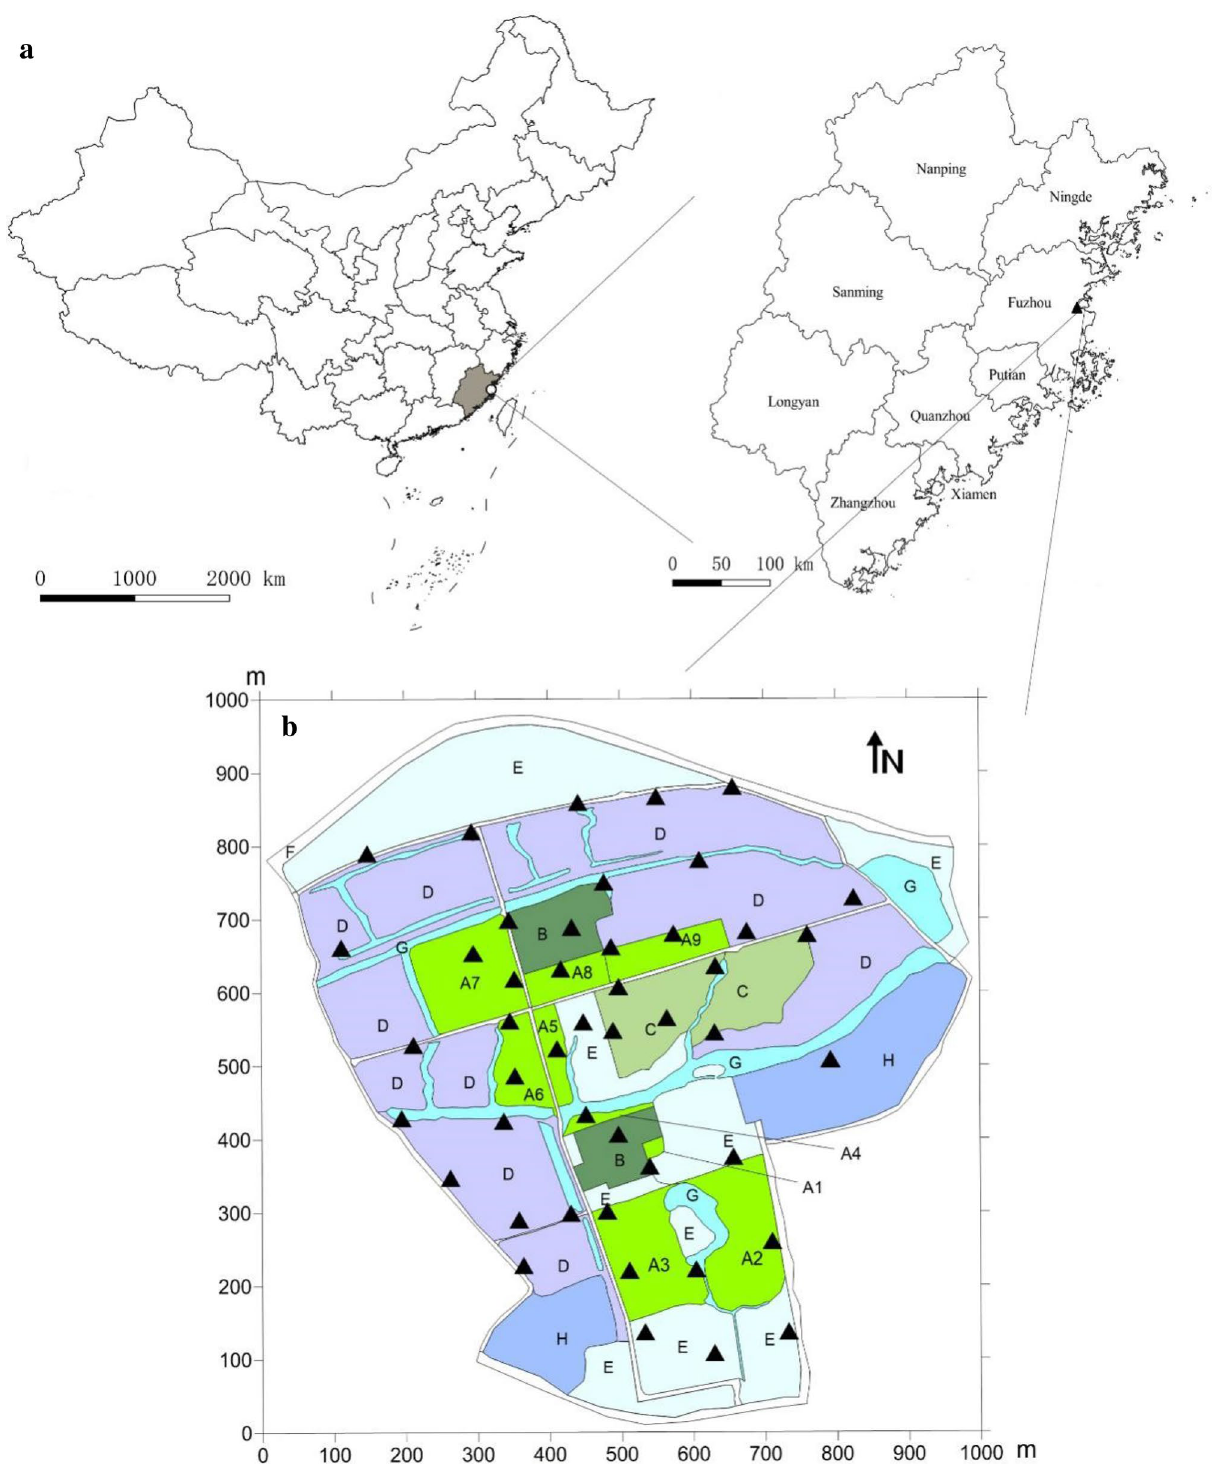
Figure 1. Geographical location and landscape composition of the study area. ( a ) The map was downloaded from the National Geomatics Center of China (http:// www. ngcc. cn/ ngcc/); ( b ) the base map was created using QGIS 3.0 based on the aerial photo of farm. A1–A9: Cruciferous vegetables grown in different patches (Table 1). B: Polytunnels, C: Rice fields, D: Pastures, E: Wastelands, F: Roads, G: Water bodies, H: Residential areas. Triangles ( ▲ ) represent traps placed in different patches within the study